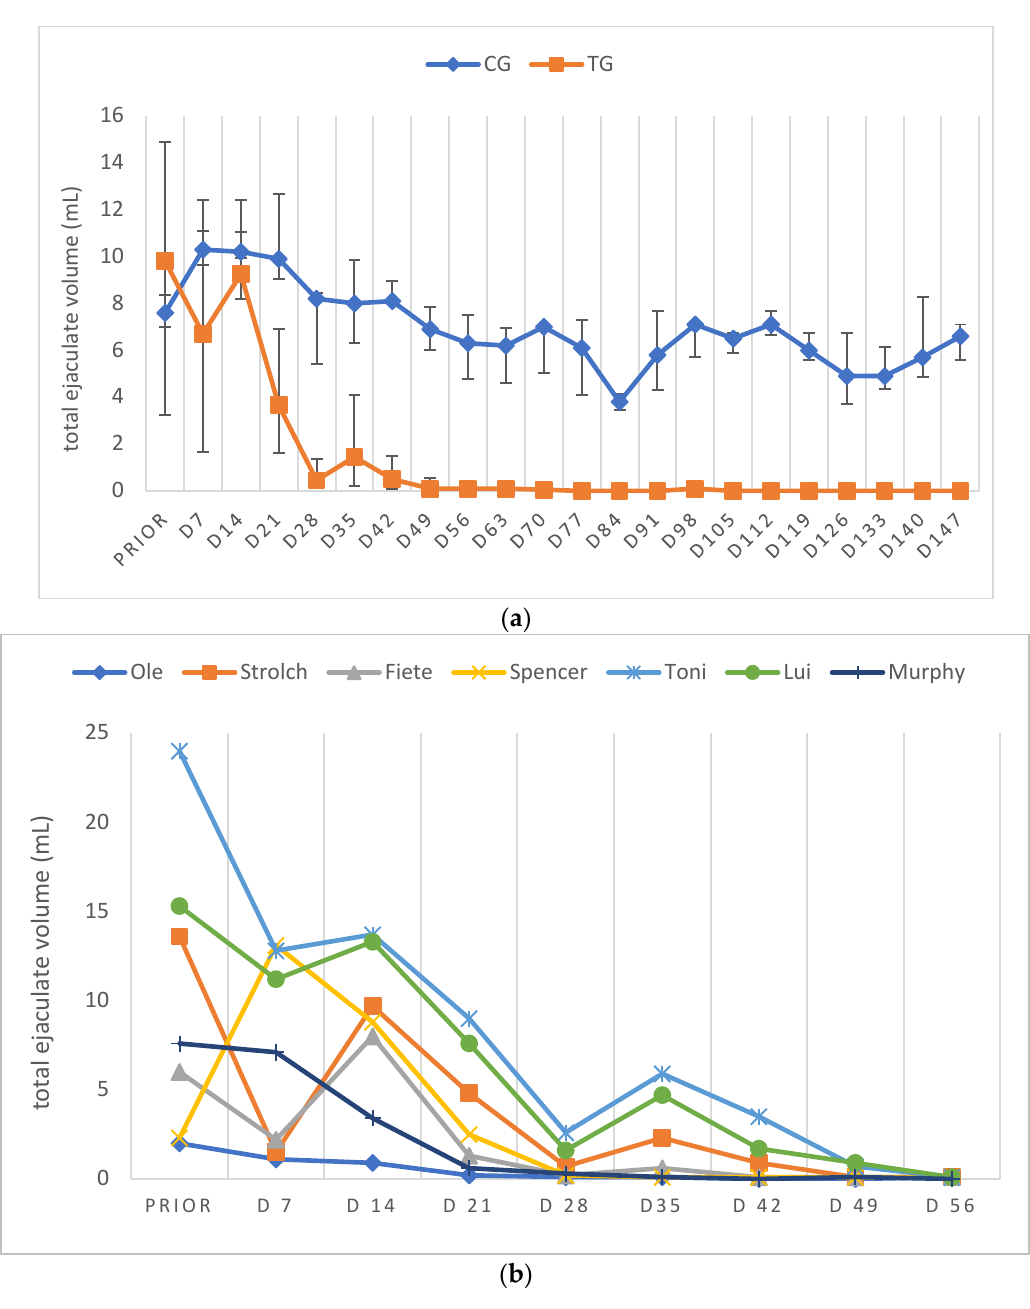
Figure 4. ( a ) Total ejaculate volume (mL) given over time (prior to treatment to D147) as median (Q1, Q3) of animals treated with a 4.7 mg deslorelin implant (TG, n = 6) and saline-treated control animals (CG, n = 3). “Prior” indicates “prior to treatment”. ( b ) Total ejaculate volume (mL) given as individual courses of animals treated with a 4.7 mg deslorelin implant (TG, n = 7) over time. “Prior” indicates “prior to treatment”.